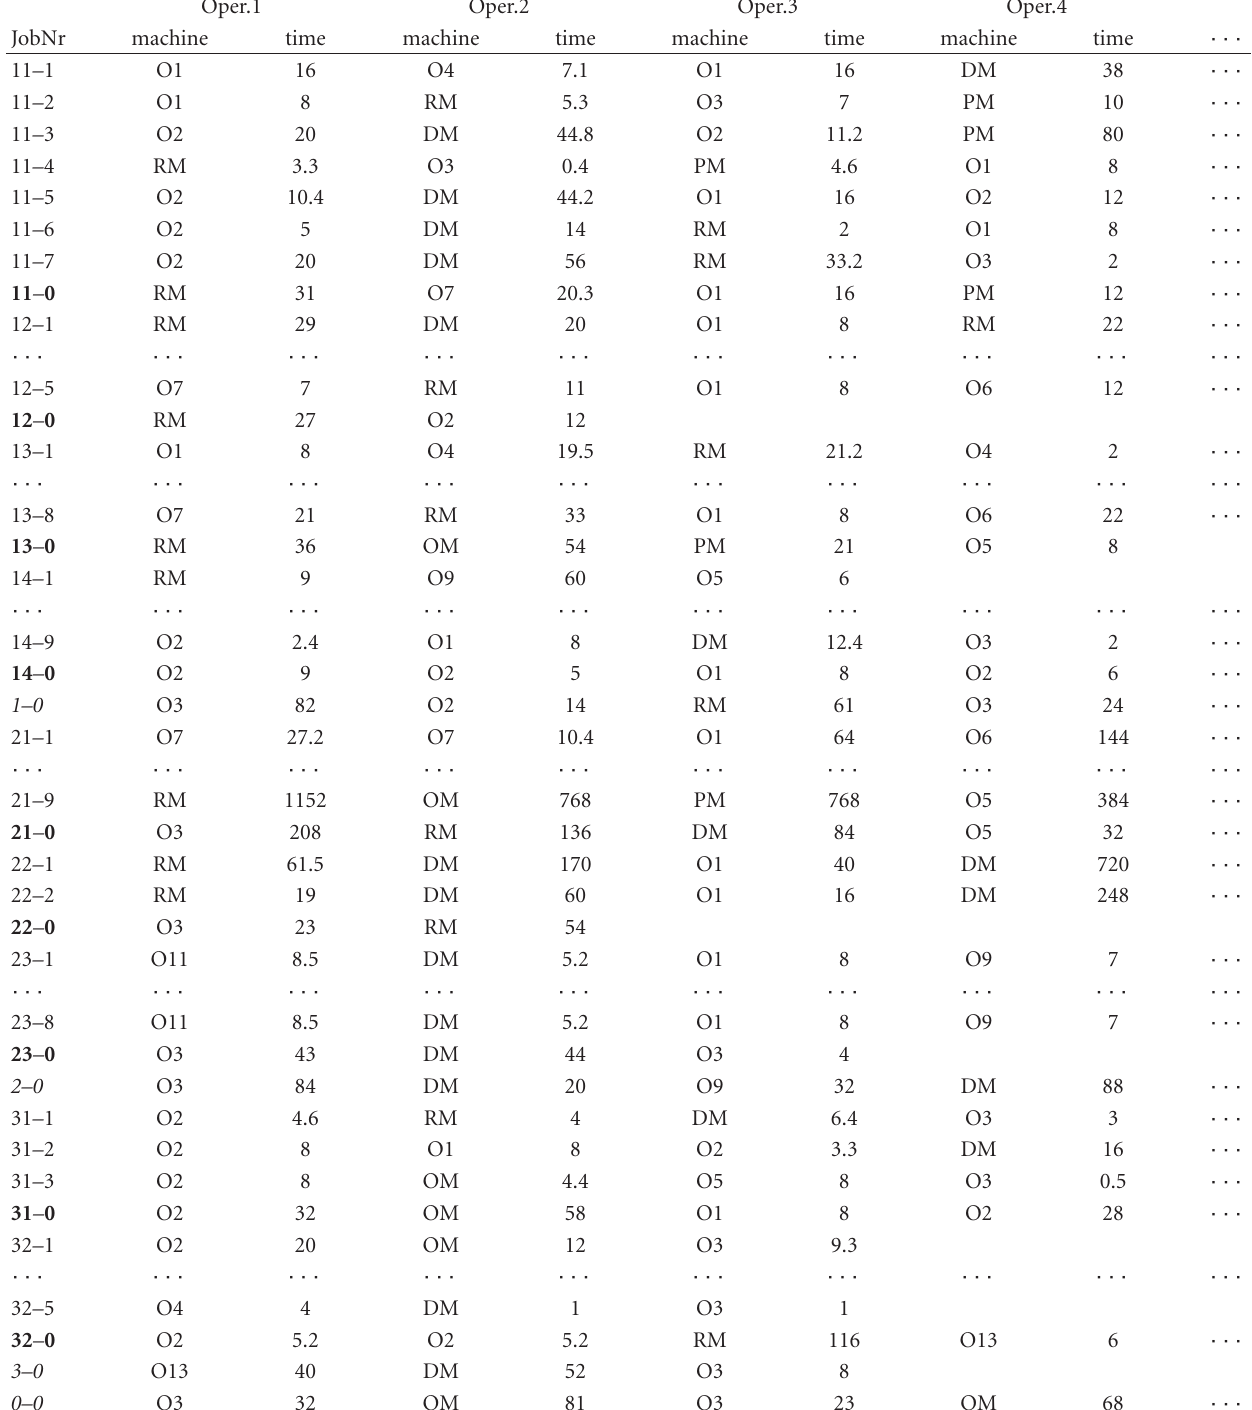
Table 1: The raw data of case study problem.